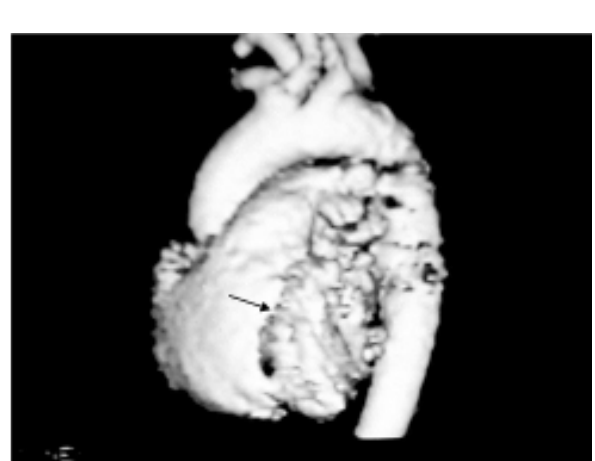
Fig. 3 - Angioressonância de paciente com sarcoma de ventrículo esquerdo. Notar o aspecto infiltrativo e irregular da parede do ventrículo esquerdo